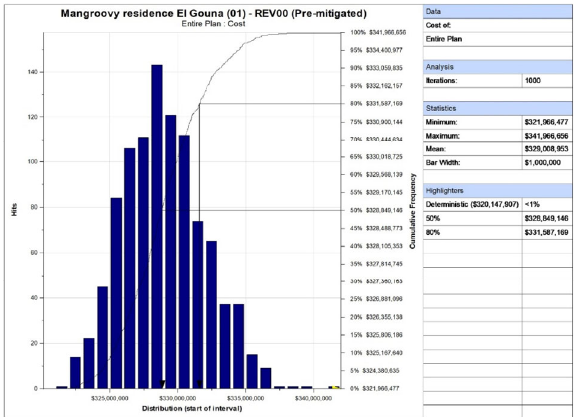
Fig. 10: Cost check simulation histogram – completion works Fig. 10. Alt Text: Cost check simulation histogram – completion works: Under the influence of risk with a confidence of 80%, the project cost will reach 331,587,169.0 $